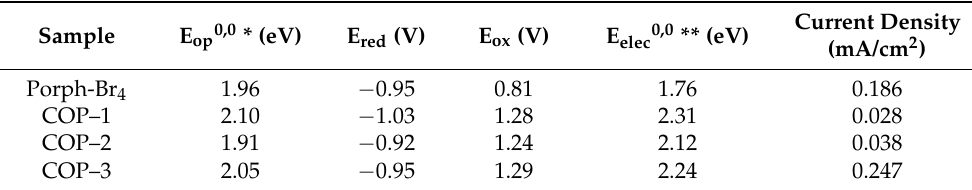
Table 3. Summary of the electrochemical properties of the Porph-Br 4 monomer and the three COPs. Samples measured in acetonitrile utilizing TBAPF 6 0.2 M as